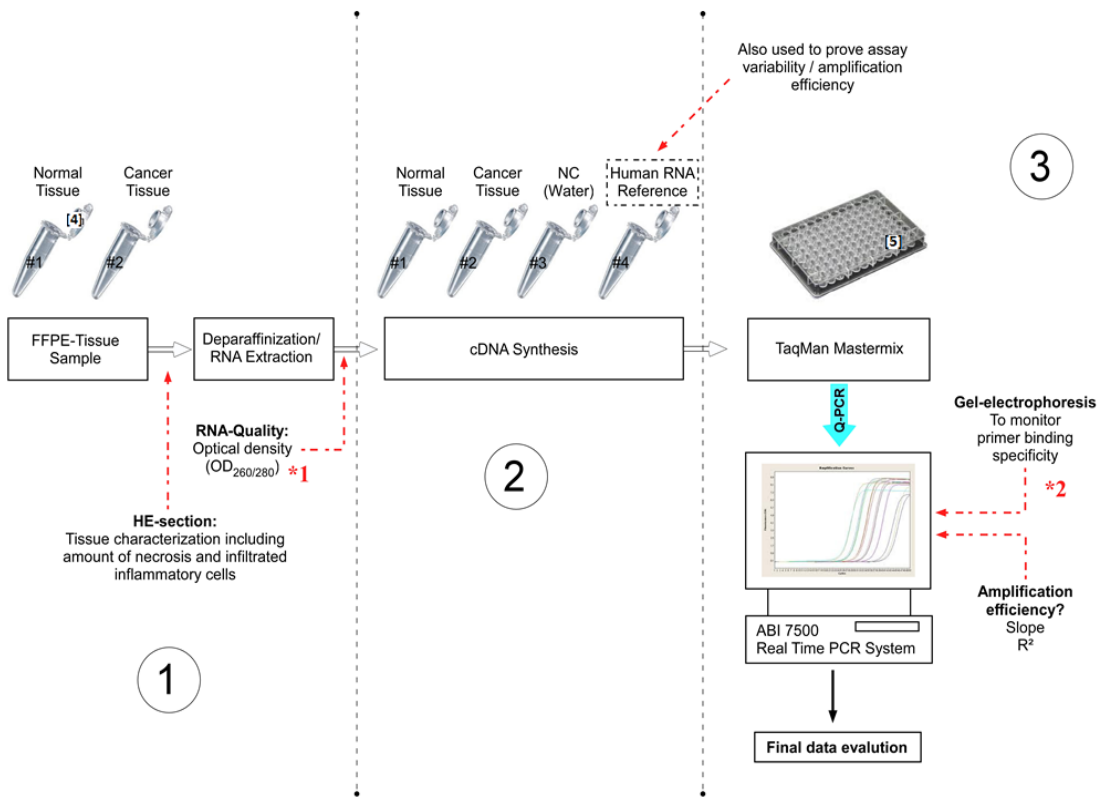
Figure 1. Experimental design (Step 1–3) of the present study, including important checkpoints (  ) to provide quality assessment. (NC = Negative